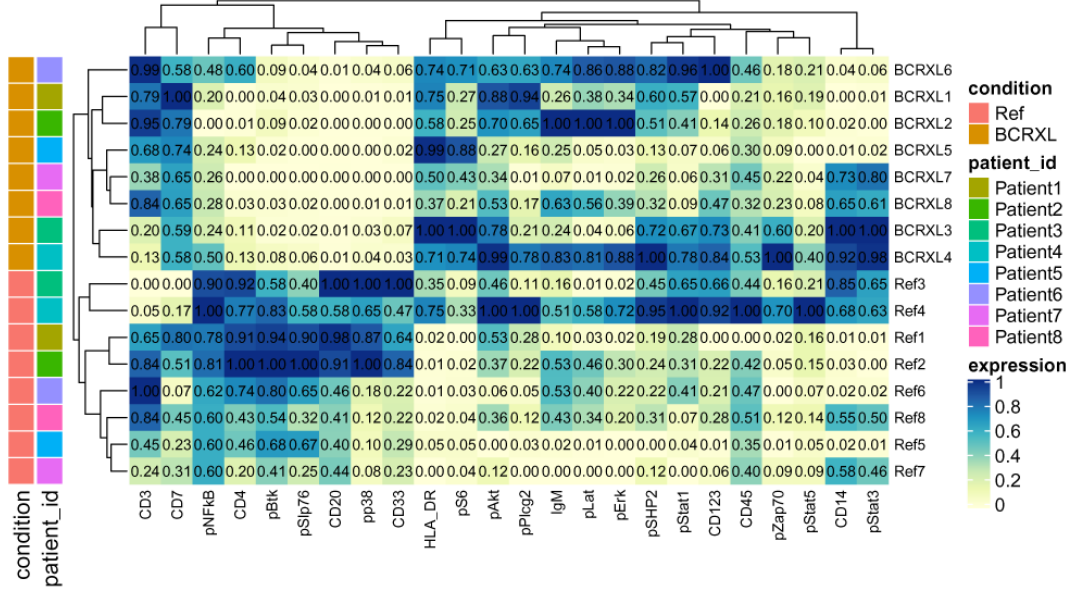
Figure 4. Heatmap of the median (arcsinh-transformed) marker expression of 10 lineage markers and 14 functional markers across all cells measured for each sample in the PBMC dataset. Color-coded with yellow for lower expression and blue for higher expression. The numbers in the heatmap represent the actual expression values. Dendrograms present clustering of samples (rows) and markers (columns) which is based on hierarchical clustering with Euclidean distance metric and average linkage. Row annotations on the left of the heatmap represent the two conditions: unstimulated (Ref) and stimulated with BCR/FcR-XL (BCRXL), and patient IDs for each of the 8 healthy